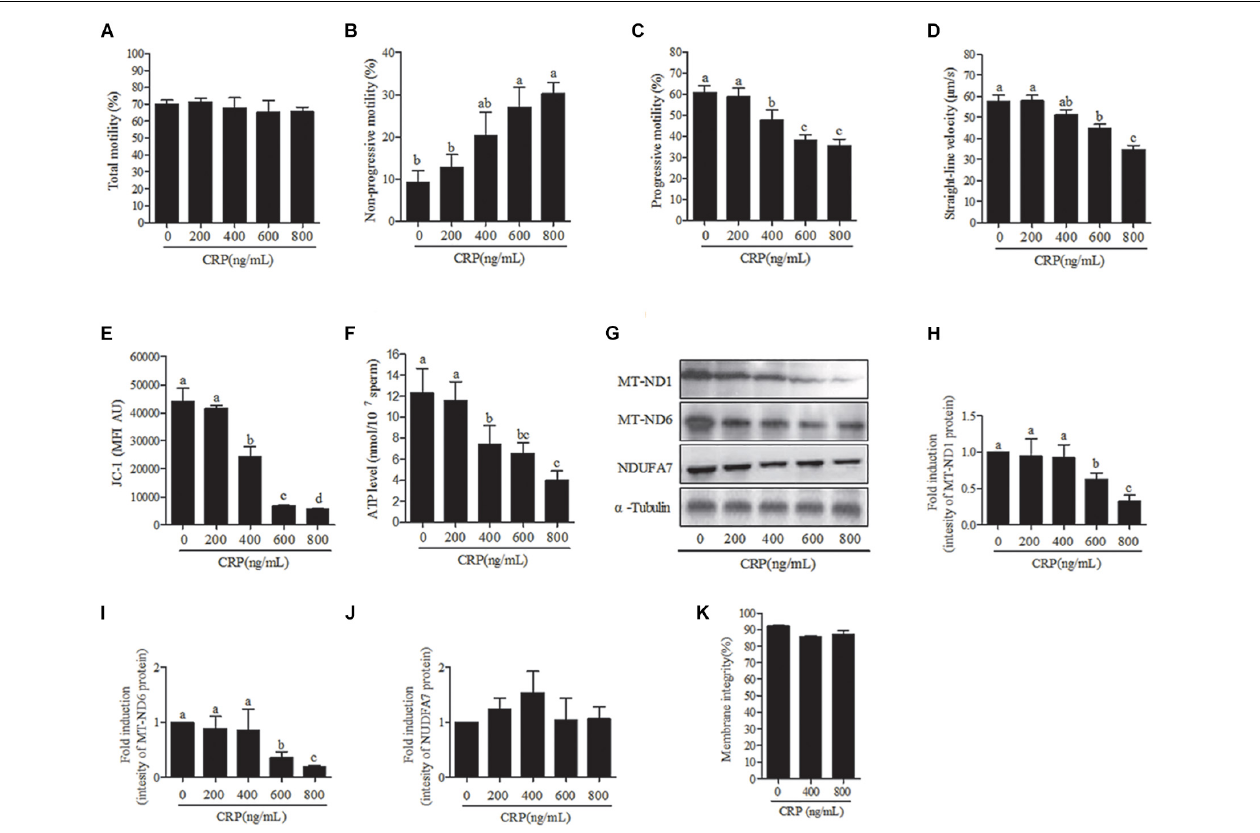
FIGURE 4 | Effect of D -chloramphenicol (CRP) on boar sperm at 3 h incubation with different doses (0, 200, 400, 600, 800 ng/mL). (A–F) Dose-dependent changes in the sperm (A) total motility, (B) non-progressive motility, (C) progressive motility, (D) straight-line velocity, (E) mitochondrial activity, and (F) ATP level. (G) Western blotting image showing the expression of the MT-ND1, MT-ND6, NDUFA7, and α -tubulin. (H–J) Quantitative expression of the MT-ND1, MT-ND6, and NDUFA7 over α -tubulin (control) generated from western blotting. (K) Membrane integrity measured in sperm. Values are means ± SEM of three replicates. Columns with different lowercase letters differ significantly ( p <